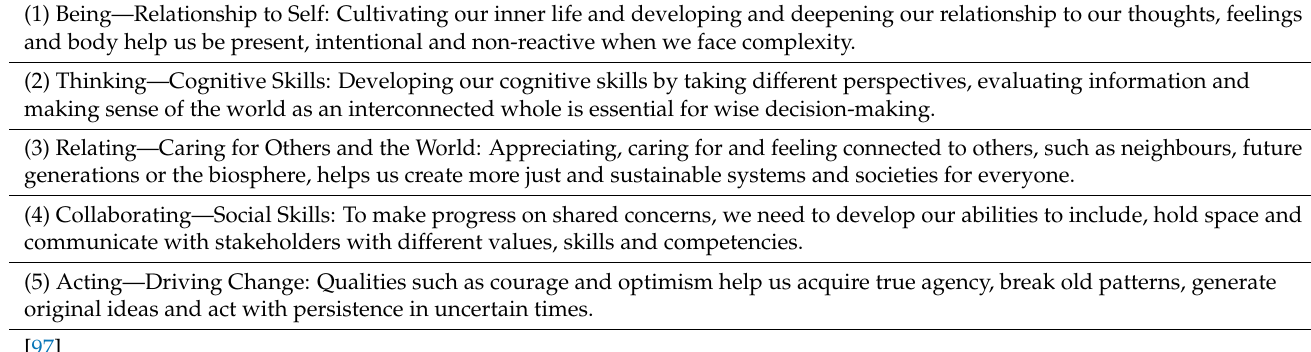
Table 2. The Inner Development Goals